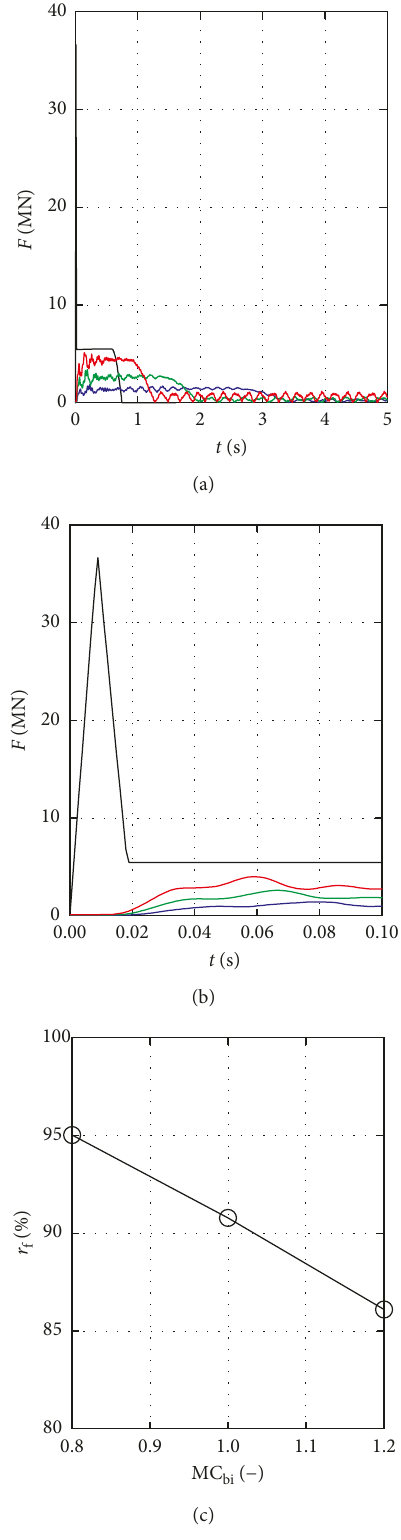
Figure 10: Impact force time histories on the bridge pier for the whole impact process (a), for the first 0.10s of impact process (b) corre- sponding to different beam cross-section dimensions, and the reduction ratio of maximum impact force versus MC bi